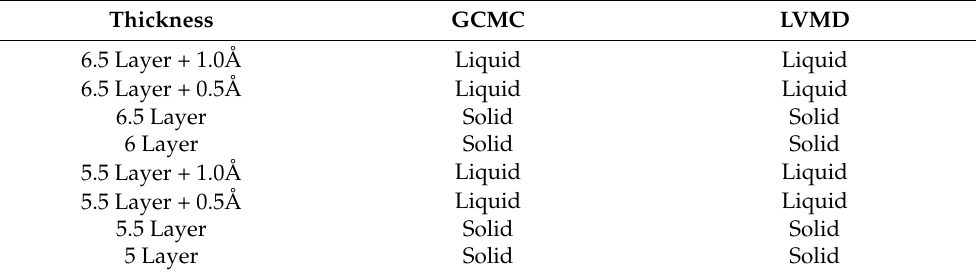
Table 2. The equilibrium phase in different thicknesses predicted by GCMC/MD simulations with chemical potential µ = − 2.21 kcal/mol (Figure 6) and liquid-vapor molecular dynamics (LVMD) simulations (Figure